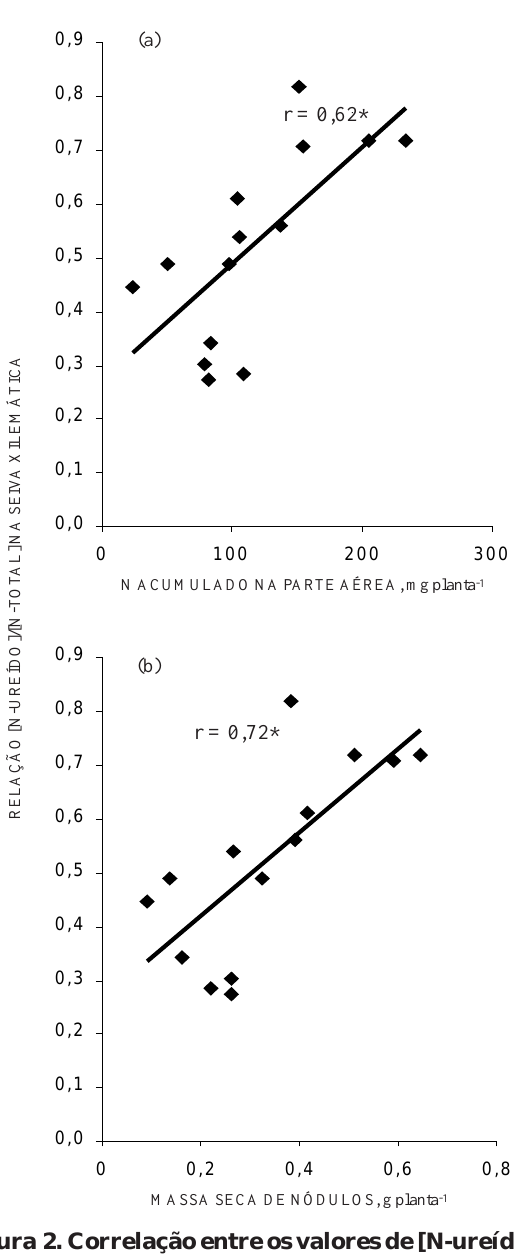
Figura 2. Correlação entre os valores de [N-ureído]/ [N-total] na seiva xilemática de guandu e as variáveis N total acumulado na parte aérea (a) e matéria seca de nódulos por planta